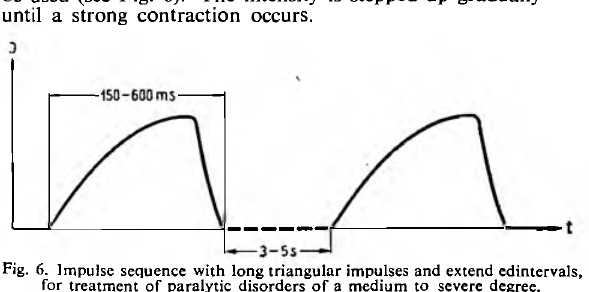
Fig. 6. Impulse sequence with long triangular impulses and extend edintervals, for treatment of paralytic disorders of a medium to severe